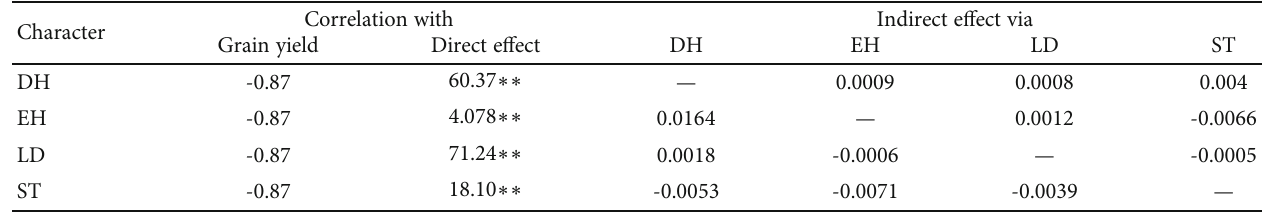
Table 7: Direct and indirect e ff ects of B. fusca damage traits on total grain yield at Kabete site.